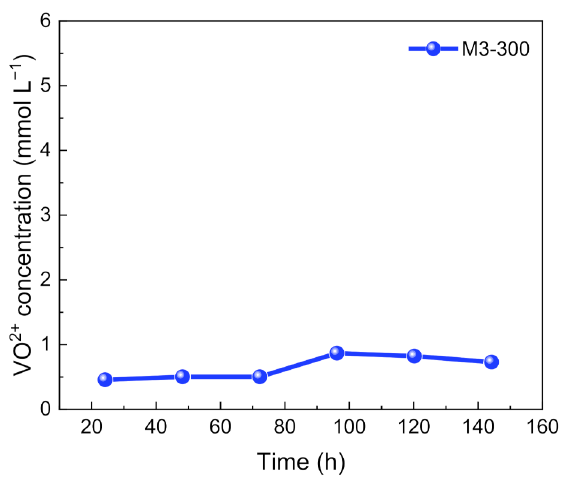
Figure 8. The results of the oxidation stability for M3-300